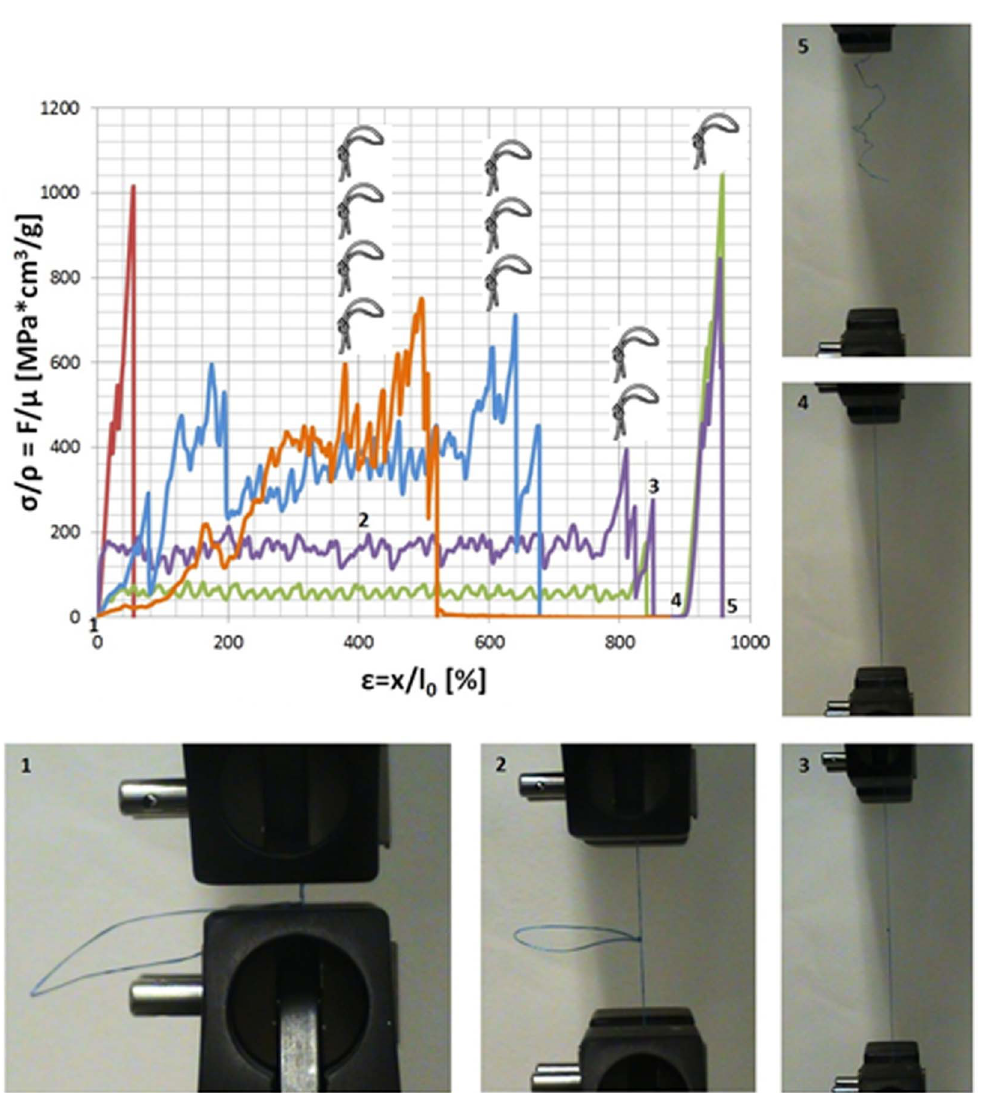
Figure 2. Proof of concept. Specific force-displacement or stress-strain curves of knotted and unknotted Dyneema fibres (the number of knots is depicted for each curve; s = r ~ F = m with m ~ r A mass per unit length, given in MPa*cm 3 /g or, equivalently, in J/g; test parameters are dx/dt=2 mm/ min, l 0 =10 mm, l=100 mm, m =0.0361 g/m). The appearance with the knot of the hidden toughness, the plastic-like plateau absent in the constitutive law of the unknotted fibre (27 J/g), is evident. For 1 and 2 coils the knot unties (peculiar mechanism) and stress goes to zero, then the fibres extends, deforms and fractures at the pristine fibre strength, with an increment in the toughness of up to 722% (2 coils, 195 J/g). For 3 coils the dissipated energy is further increased up to a maximal value of 320 J/g, corresponding to a toughness increment of 1185%. For 4 coils, premature failure leads to a reduction in both toughness and failure strain. The total hidden toughness is given by the specific strength, thus for this fibre it is close to 1000